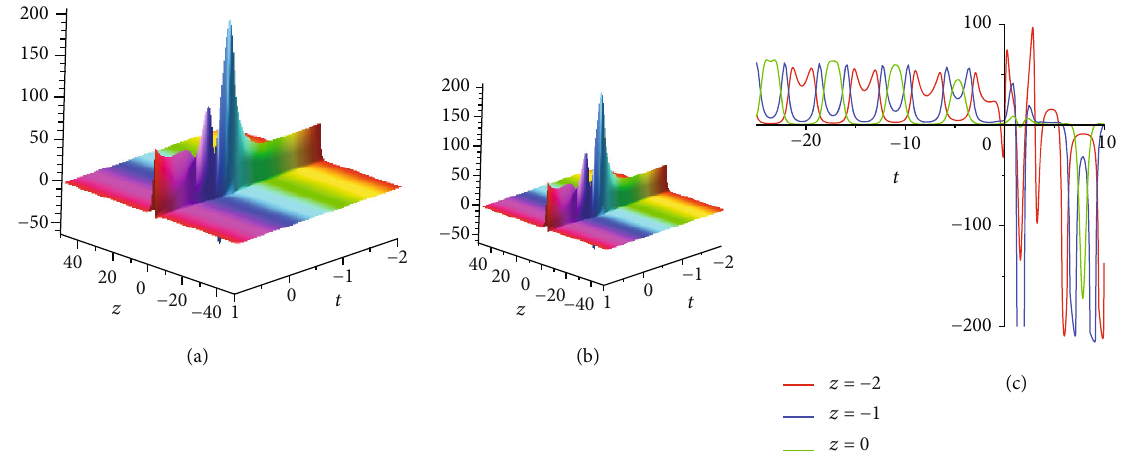
Figure 22: Plots of lump-three kink solutions